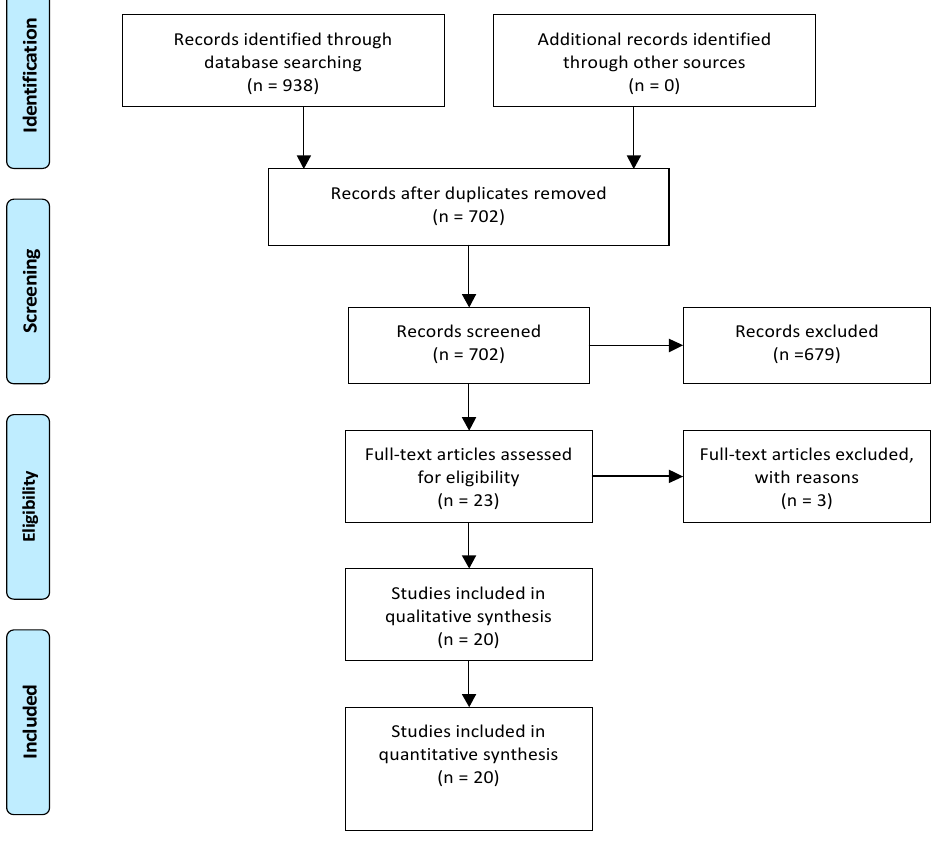
Figure 1. Search flow diagram.